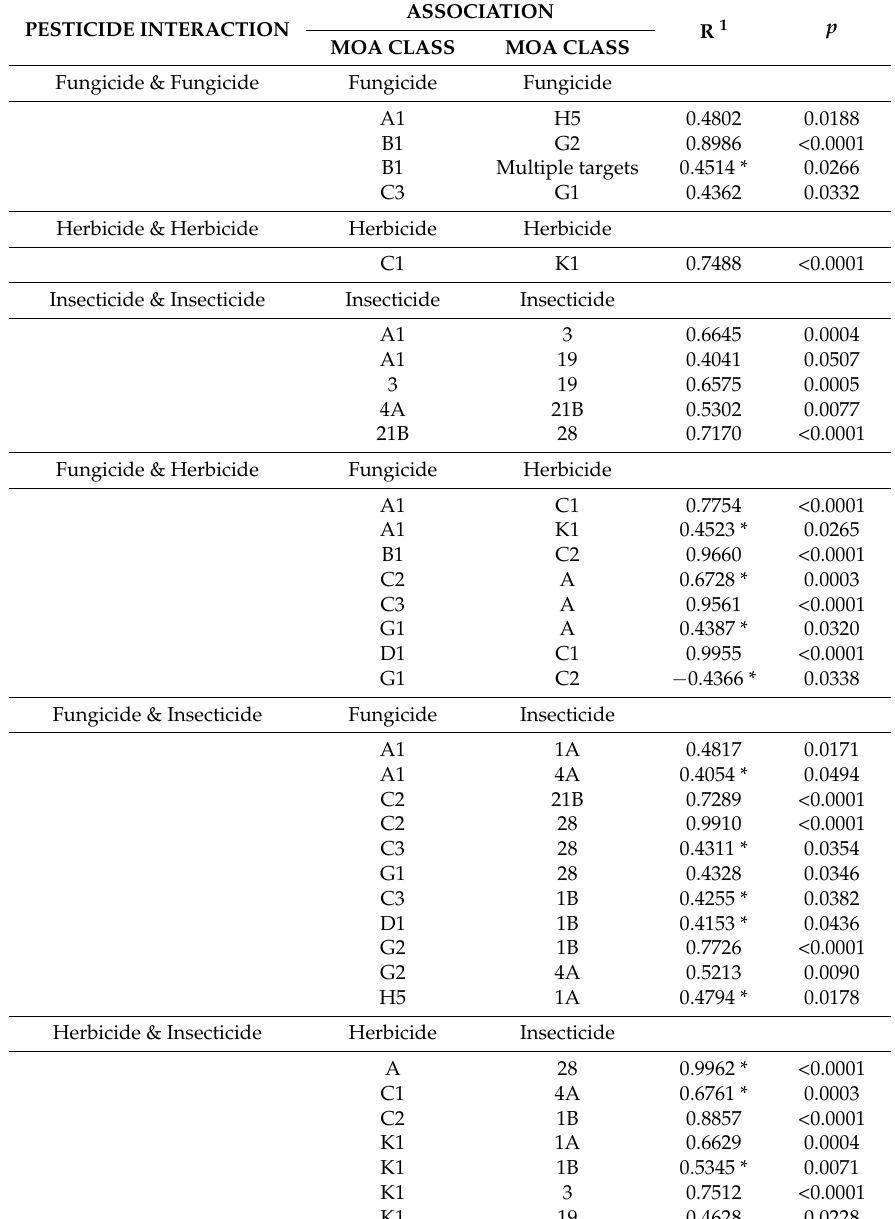
Table 9. Bivariate association (co-occurrence) among different pesticide MOA occurring in